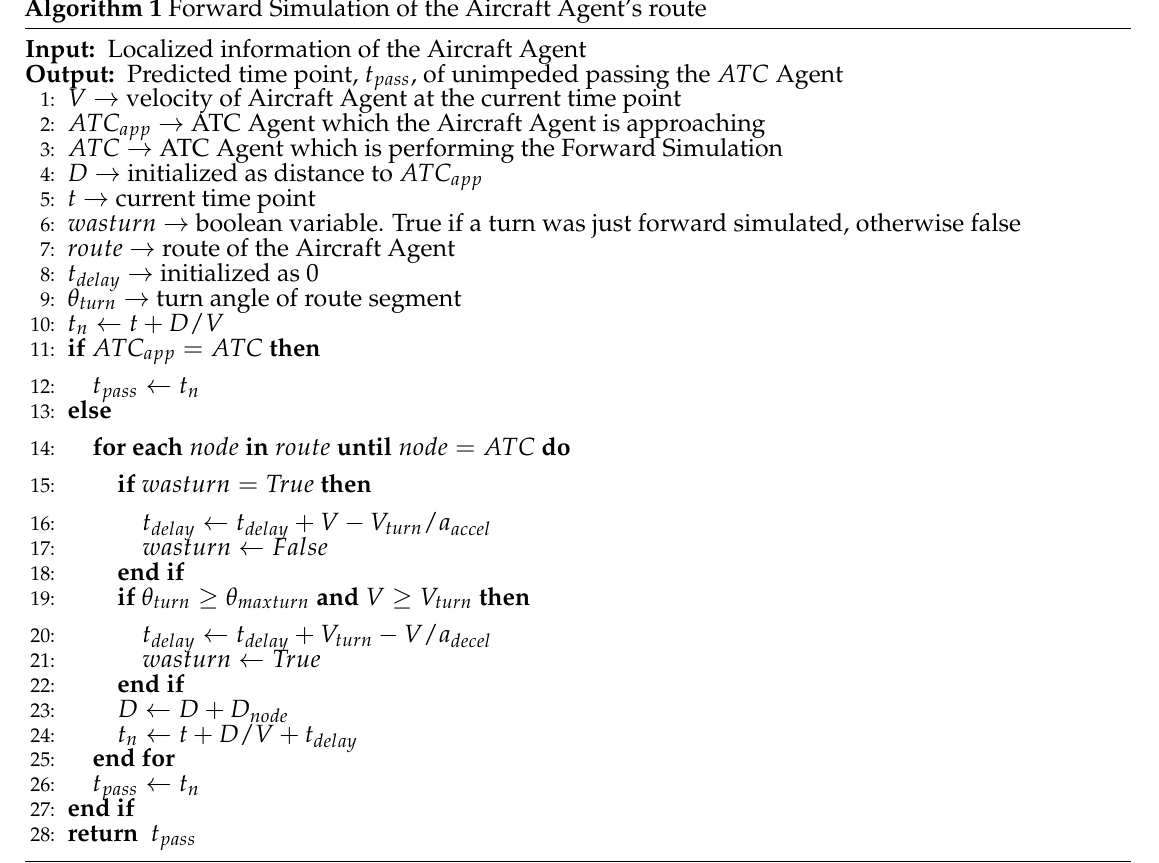
Algorithm 1 Forward Simulation of the Aircraft Agent’s